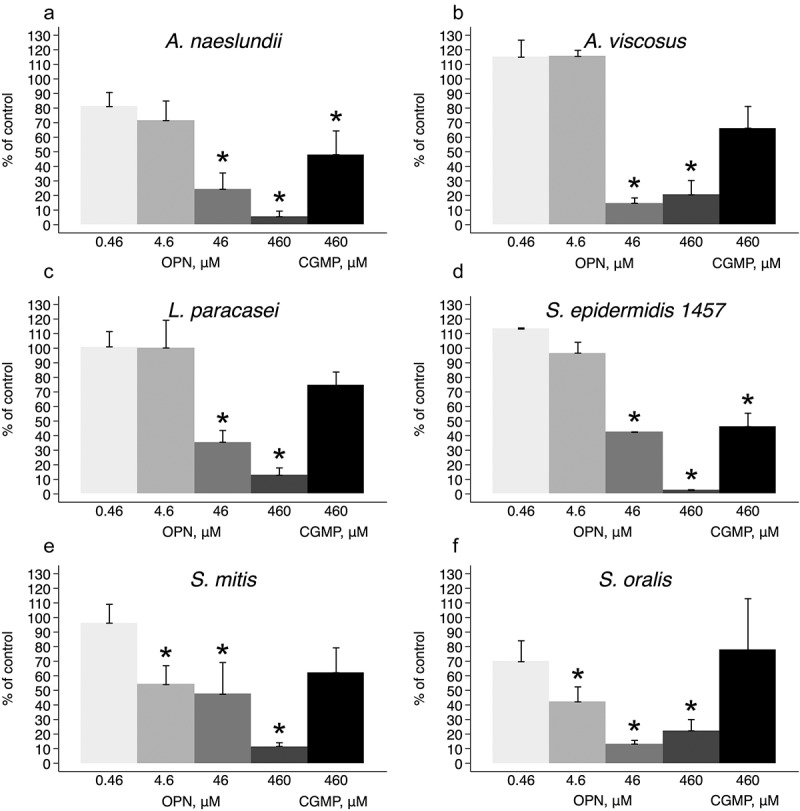
Dose-dependent effect of OPN on bacterial adhesion. Adhesion of A. naeslundii (a), A. viscosus (b), L. paracasei subsp. paracasei (c), S. epidermidis (d), S. mitis (e), and S. oralis (f) under flow was significantly reduced by 460 µM and 46 µM OPN compared to control treatment with PBS. At 4.6 µM OPN, only S. mitis and S. oralis were affected; at 0.46 µM OPN, the effect ceased. CGMP (460 µM) had a weak effect on adhesion that was only statistically significant for S. epidermidis and A. naeslundii. Error bars = standard errors of mean. *p < 0.05.